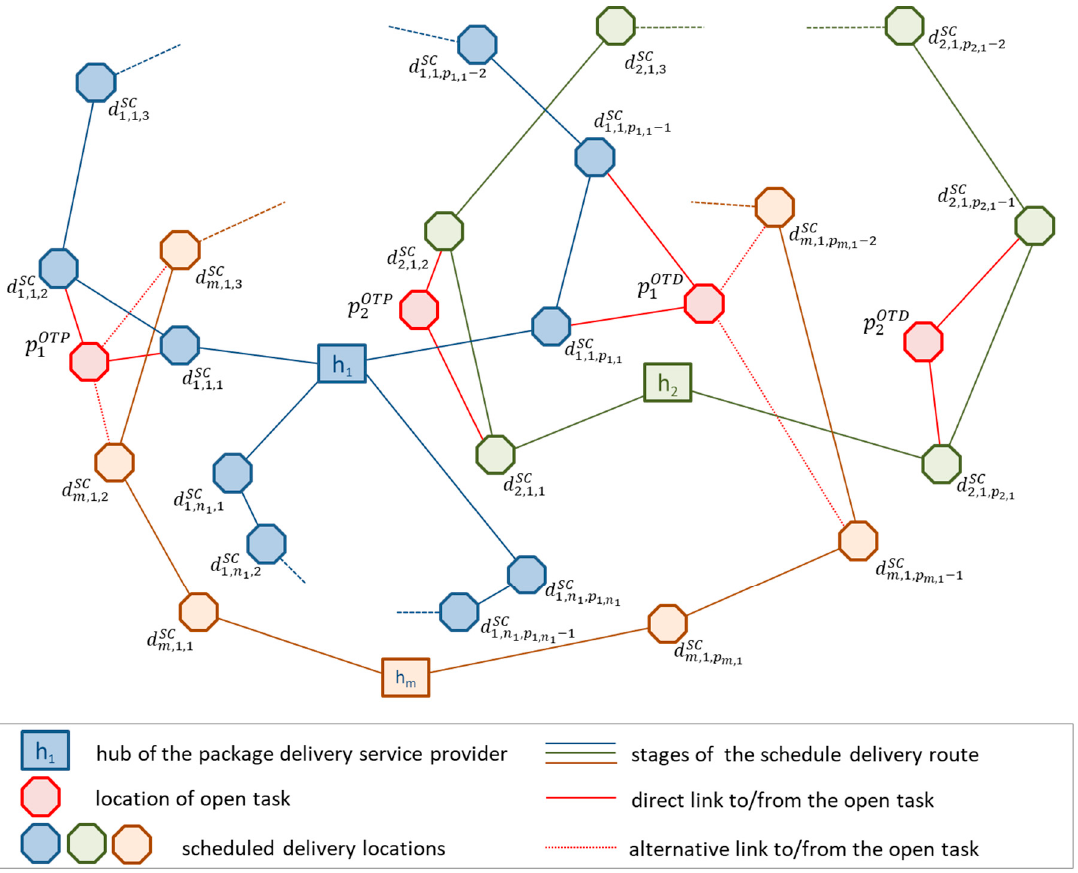
Figure 6. The model of real-time decision making in last mile logistics to optimize energy efficiency.